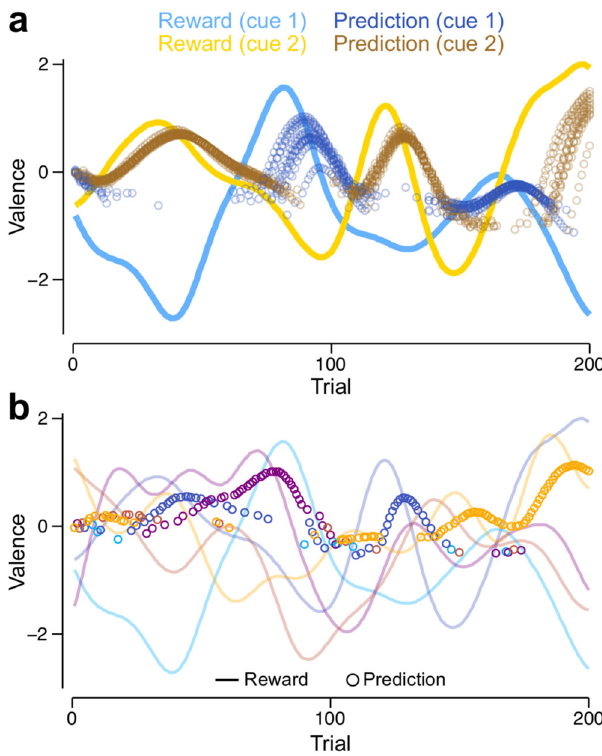
Fig. 4 Learning RPs in tasks with multiple cues. RPs are shown for the MV model, but the VS λ model exhibits almost identical behaviour. a Reinforcement schedules (lines) and RPs (circles, shown only for the cue chosen on each trial) for two cues (blue: cue 1; yellow: cue 2). RPs are shown for ten independent runs of a simulation using the same reinforcement schedule. b Reinforcement schedules (lines) and RPs (circles, shown only for the cue chosen on each trial) for a single run of the model in a task involving 5 cues. Each colour corresponds to reinforcements and predictions for a different